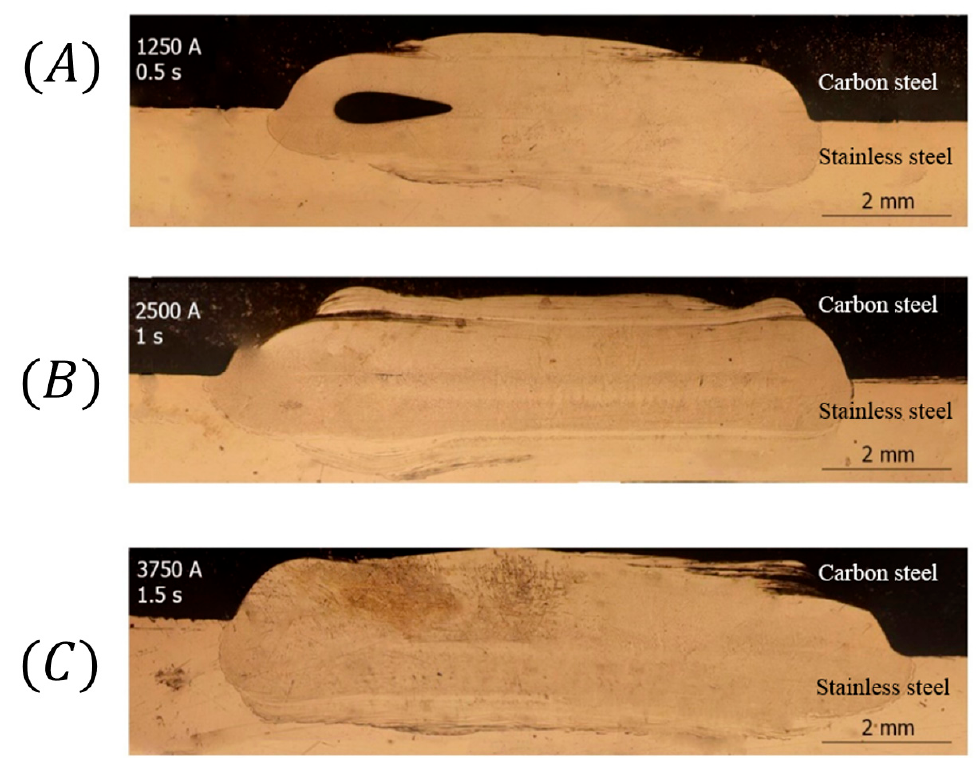
Figure 8. Macrostructure of the welding zone of dissimilar welding of 304 steel to carbon steel in different current and time conditions. ( A ) 1250 A and 0.5 s, ( B ) 2500 A and 1 s, ( C ) 3750 and 1.5 s.